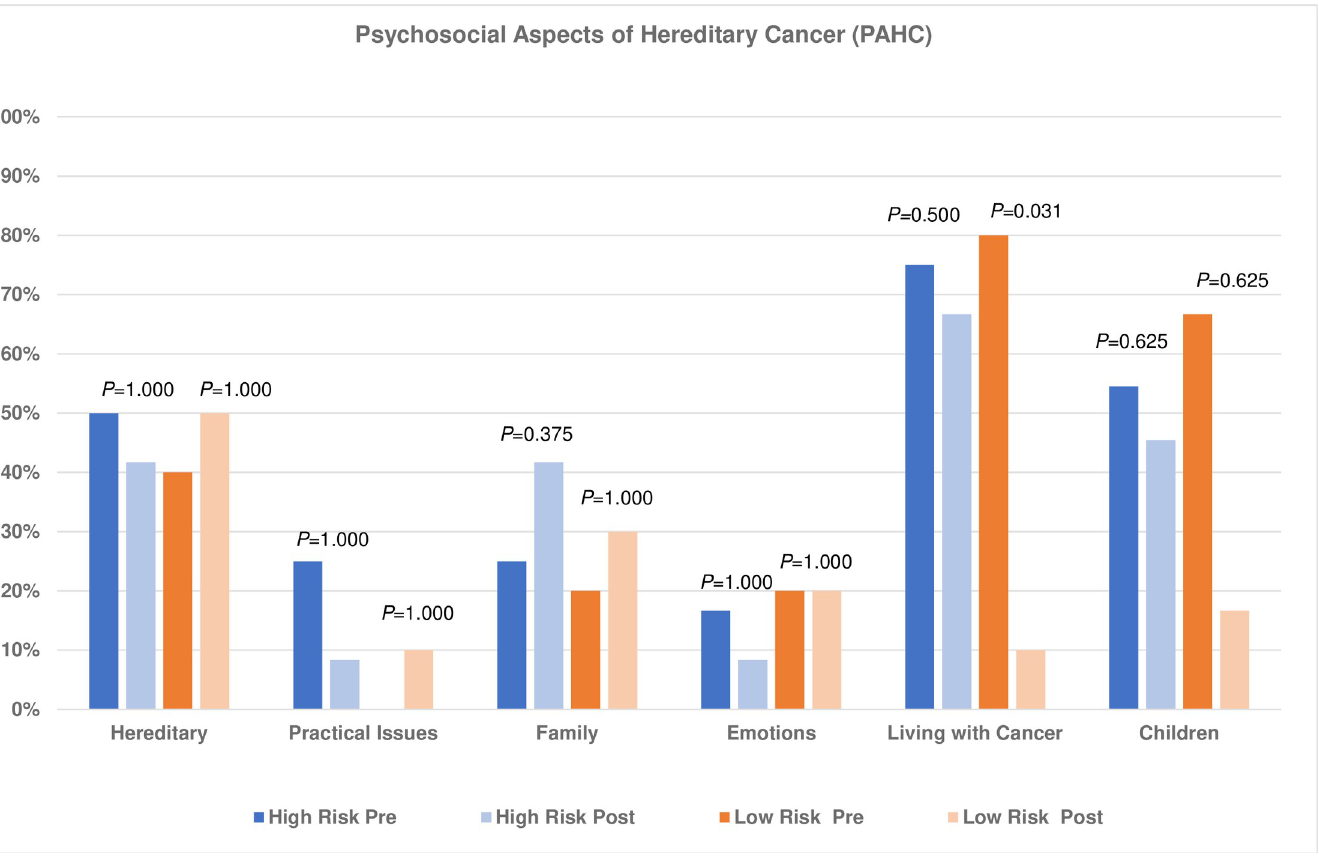
Fig 2. Psychosocial Aspects of Hereditary Cancer (PAHC) of 22 carriers pre- and post-result disclosure (two to six weeks after result disclosure). P -values for McNemar’s test comparing baseline and post-result disclosure for each domain for high and low a priori risk independently. High a priori risk carriers, N = 12; Low a priori risk carriers, N =